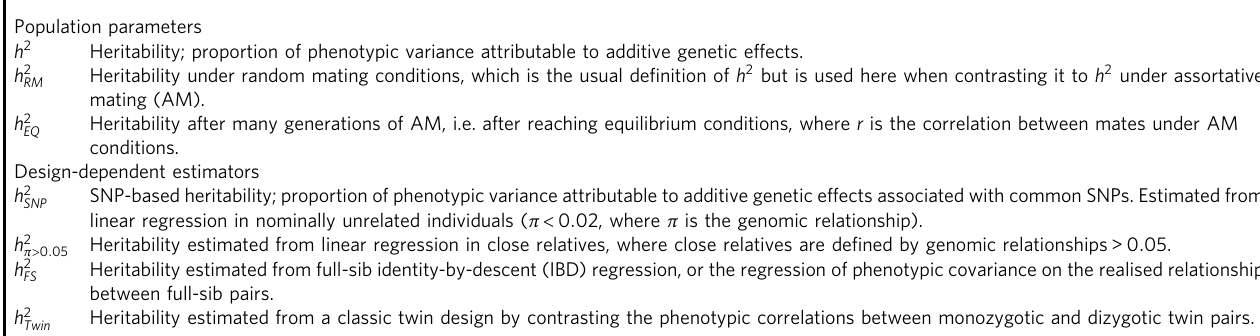
Table 1 De fi nitions of heritability and their use in this